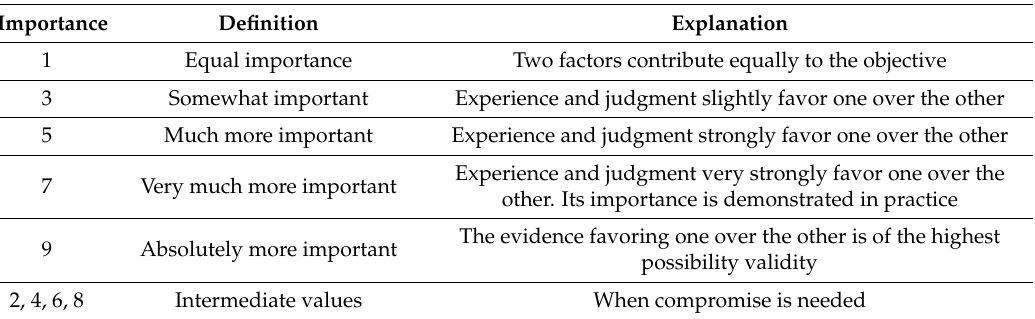
Table 1. Pairwise scale based on Saaty